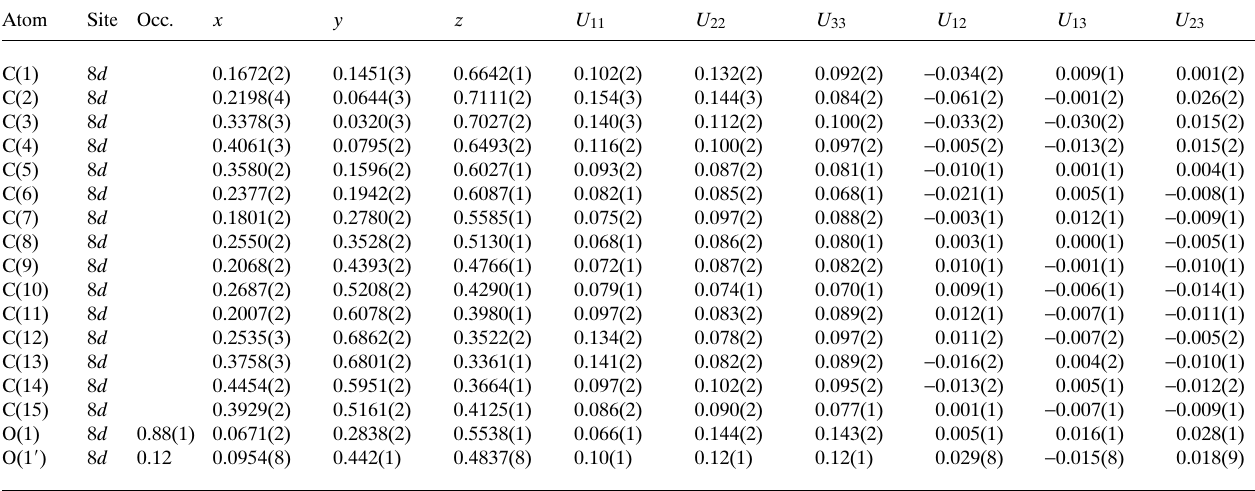
Table 3. Atomic coordinates and displacement parameters (in Å 2 ) .